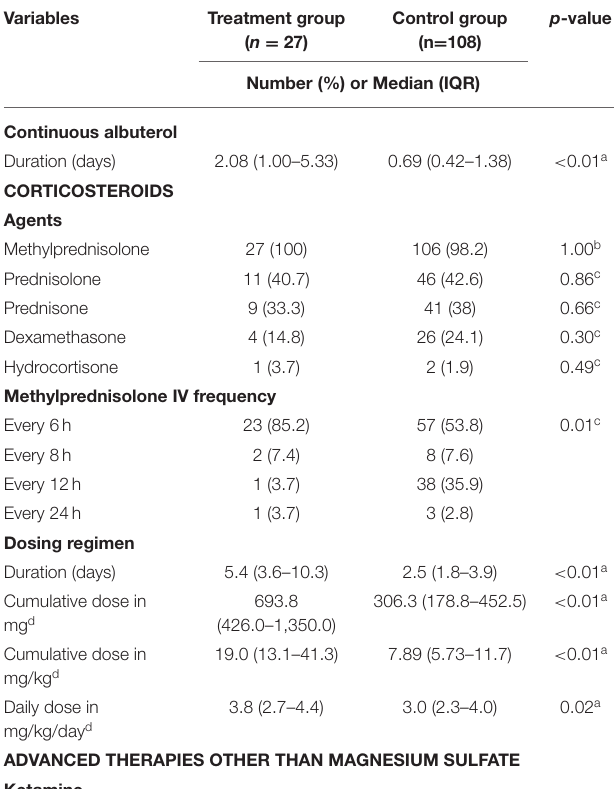
TABLE 4 | Comparison of medications received by patients in treatment vs. control groups ( n = 135).